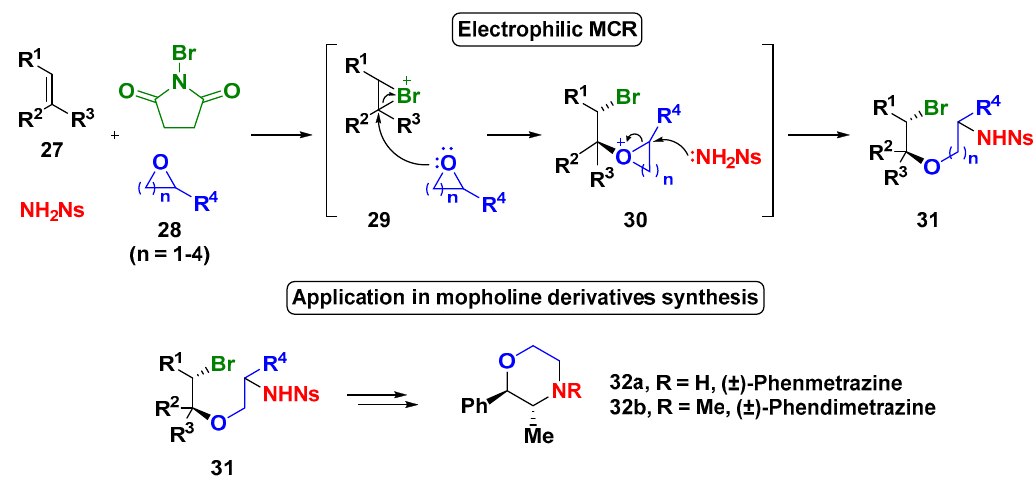
Scheme 8. One-pot electrophilic aminoalkoxylation reaction. Scheme 8. One ‐ pot electrophilic aminoalkoxylation